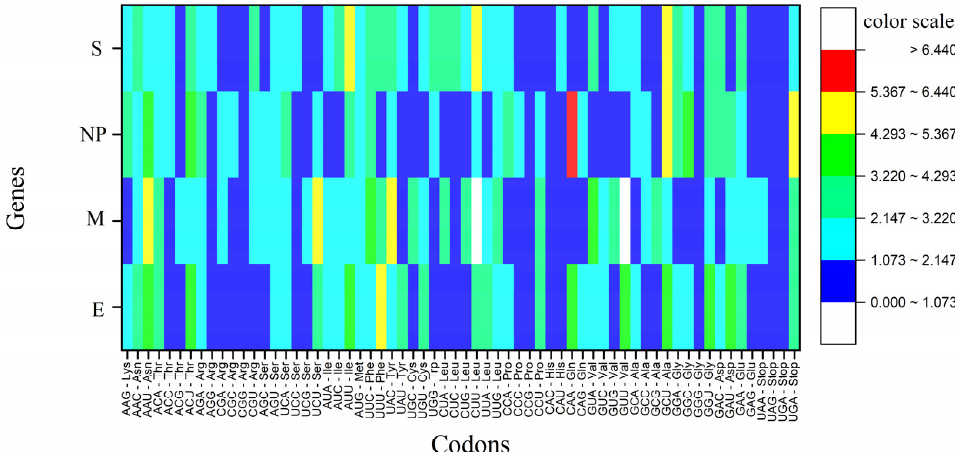
Figure 4. Heat map depicting the percent occurrence of codons in SARS-CoV-2 envisaged structural genes. Stop codons are included, and TGA is preferred over TAG and TAA. Color coding is given as a sidebar.